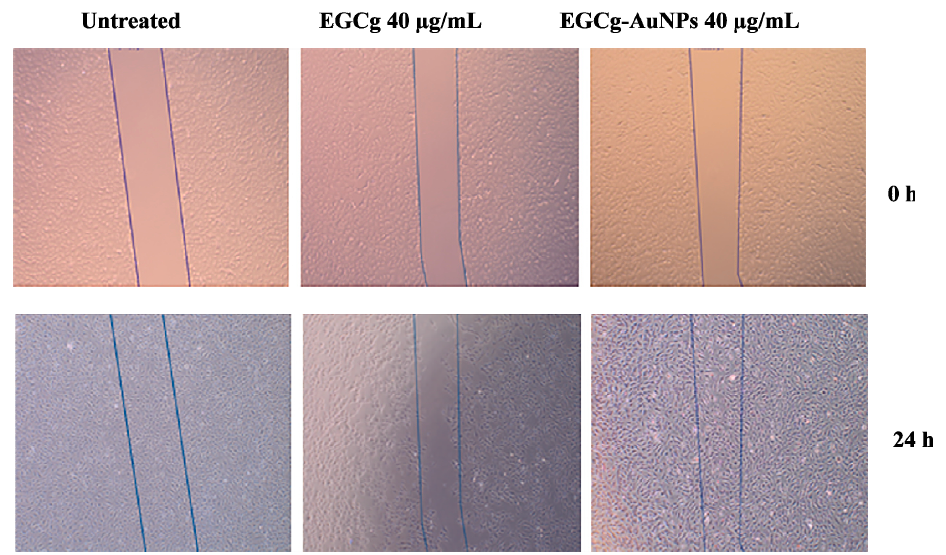
Figure 8. Inhibitory effects of EGCg-AuNPs and free EGCg on human aortic endothelial cells (HAECs) migration. Images were captured at 4× magnification.